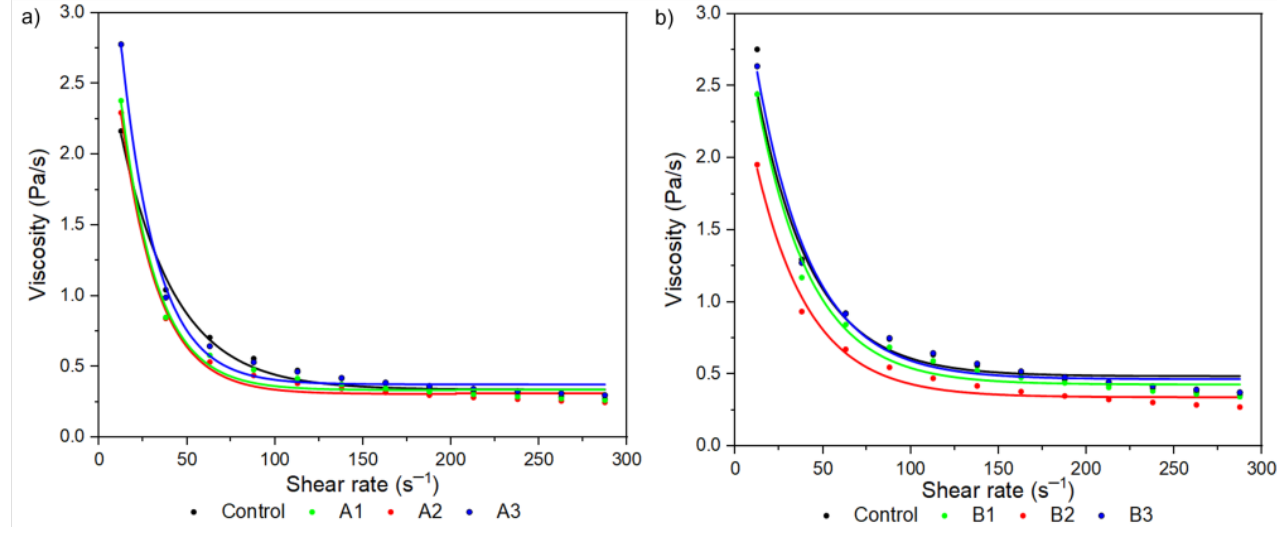
Figure 6. Viscosity of the cosmetic formulations under study, evaluated through rheological studies: ( a ) formulation A with the three incorporated extracts (A1, A2, and A3) and ( b ) formulation B with the three extracts incorporated (B1, B2, and B3).